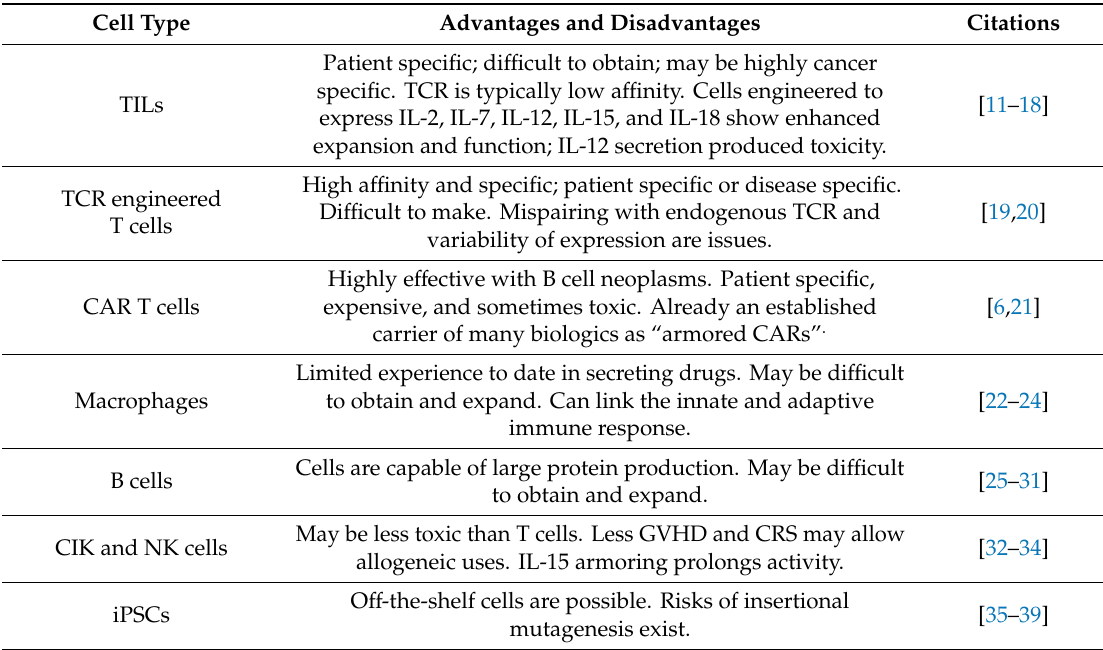
Table 1. Choices of cells in which to engineer a